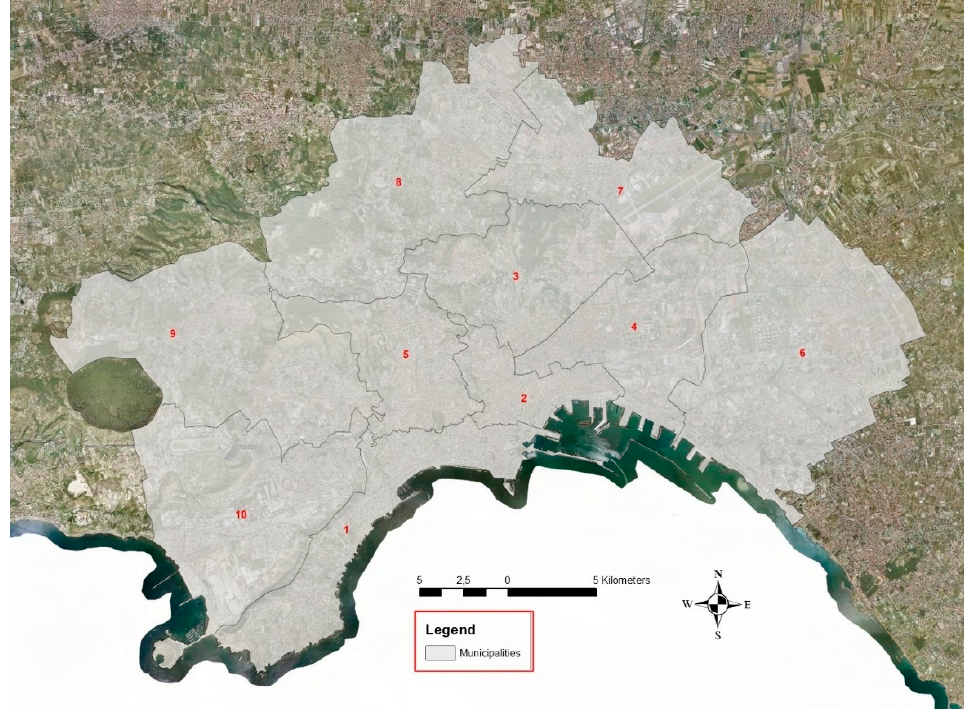
Figure 4. The study area of Naples (Italy) and its 10 municipalities.